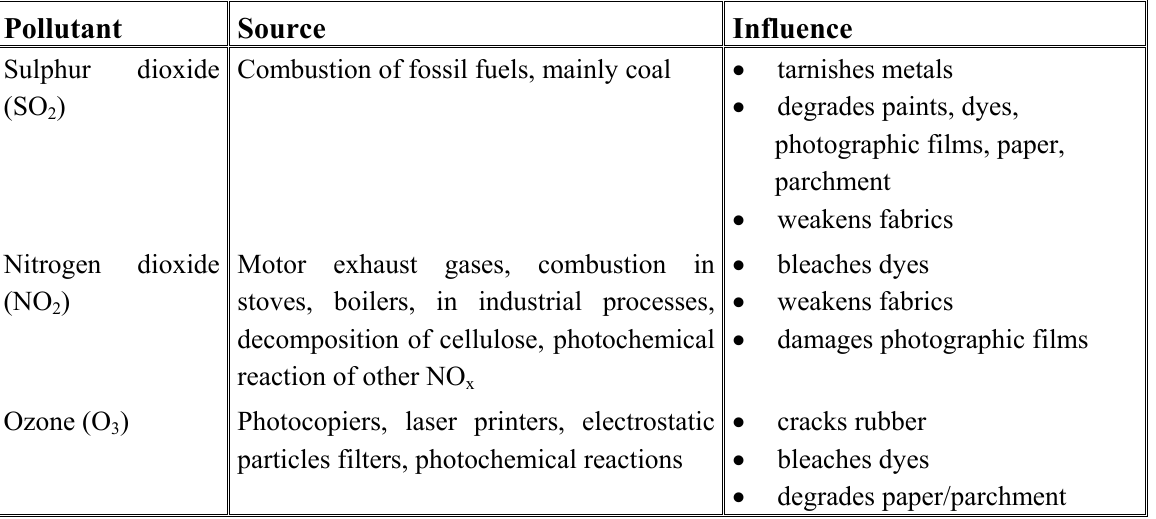
Table 1. Main atmospheric pollutants – their sources and influence on art works